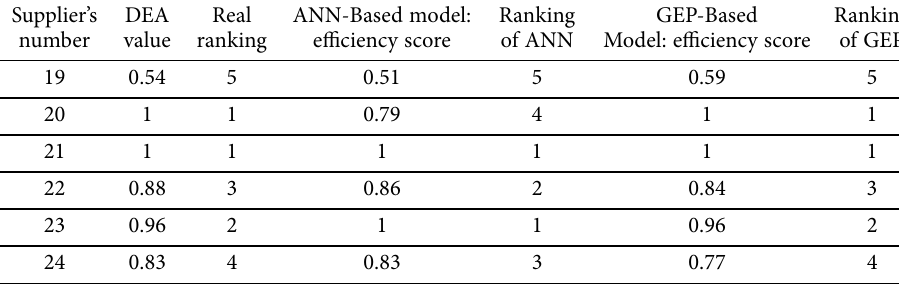
Table 6. The ranking of suppliers for testing data set Supplier’s DEA Real number value